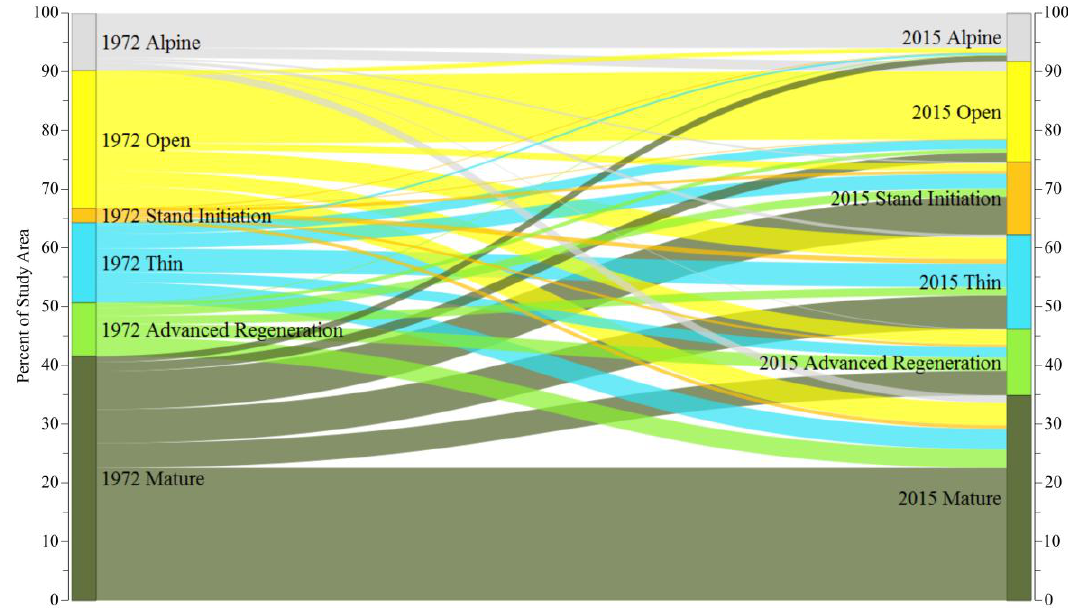
Figure 7. Sankey diagram of the state transition from one class to another of the six forest structure classes from 1972 to 2015. Y-axes show the percent of each class that covers the study area in 1972 and 2015, respectively. For instance, Mature has lost area overall, starting with 42% of the study area in 1972 and ending with 35% of the study area in 2015. If we combine the forested classes (Mature, Advanced Regeneration, and Thin, and Stand Initiation), we observe that there has been a slight increase of forest cover from 1972 to 2015, starting with 67% of the study area and ending with 74% of the study area.